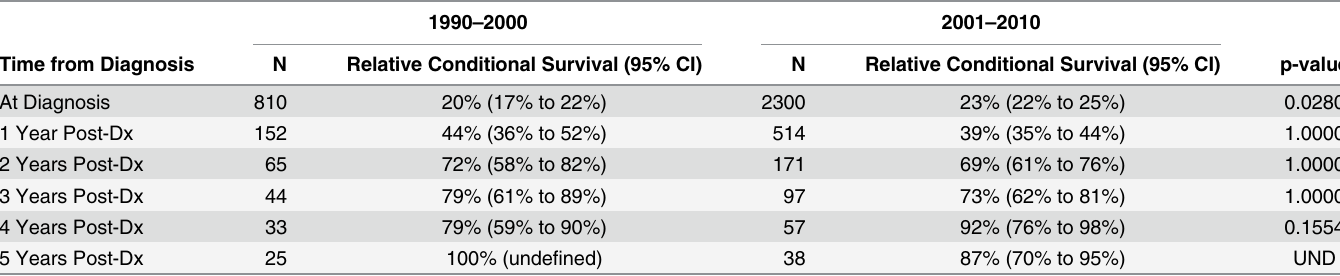
Table 4. 1 year relative conditional survival by time